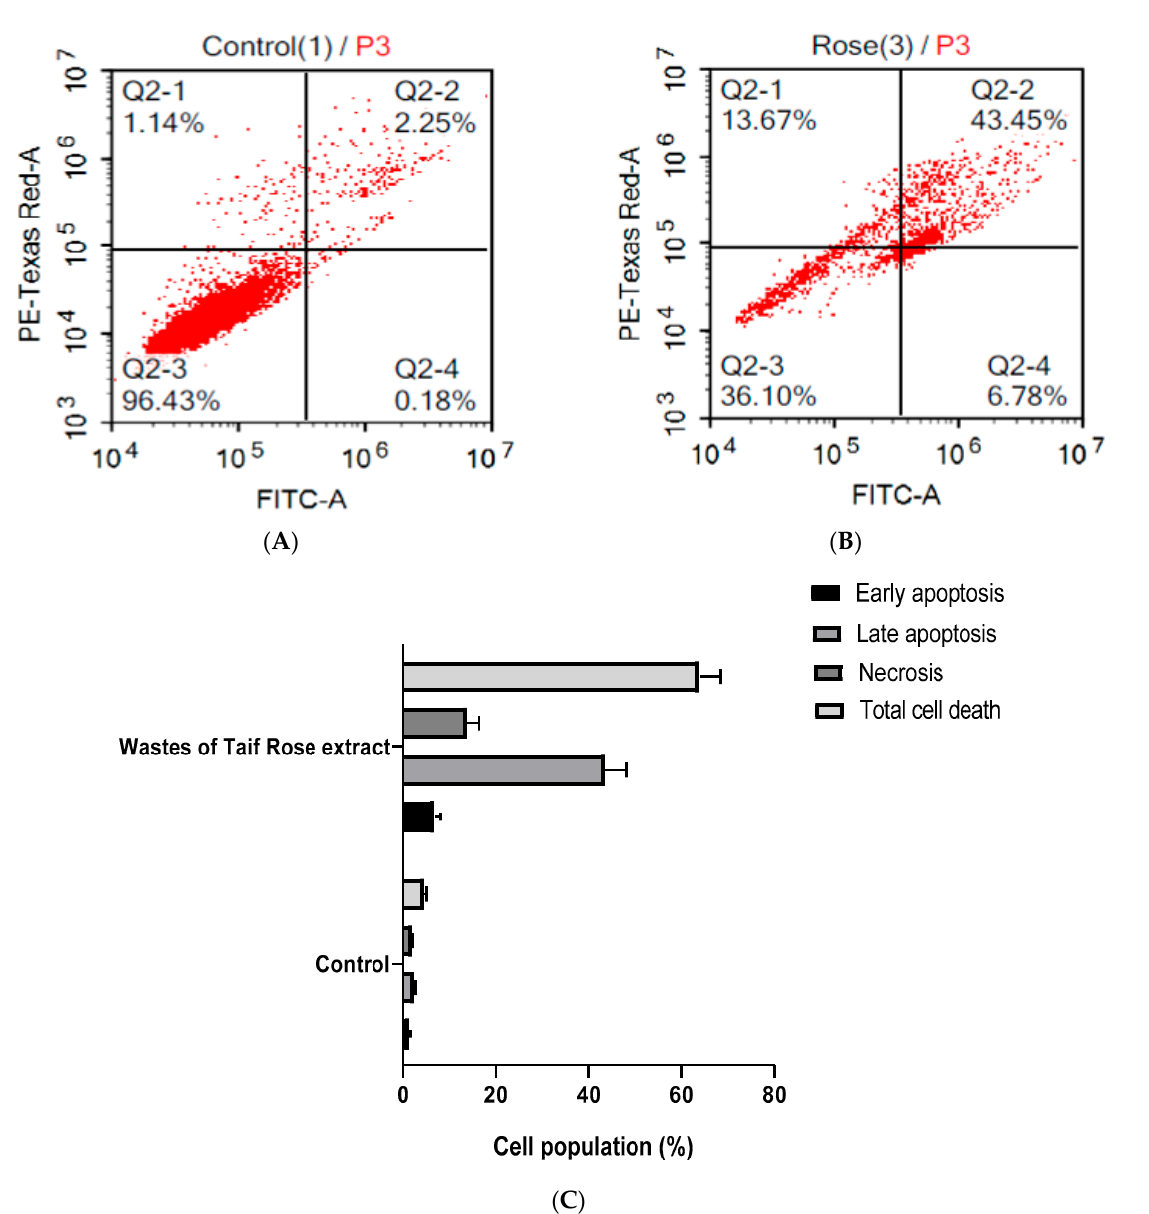
Figure 5. Apoptosis/necrosis assessment in HepG2 cells after exposure to the waste of Taif rose (WTR) ( Rosa damascene Mill var . trigentipetala ): ( A ) control, ( B ) WTR, and ( C ) statistical analysis for cell population. Induction of programmed (apoptosis) and nonprogrammed cell death (necrosis) by WTR in HepG2 cells: the liver cancer cells were exposed to WTR for 48 h. HepG2 were stained with annexin V-FITC/PI, and different cell populations were plotted as % of total cell cycle. Data are expressed as mean ± SE; n = 3.